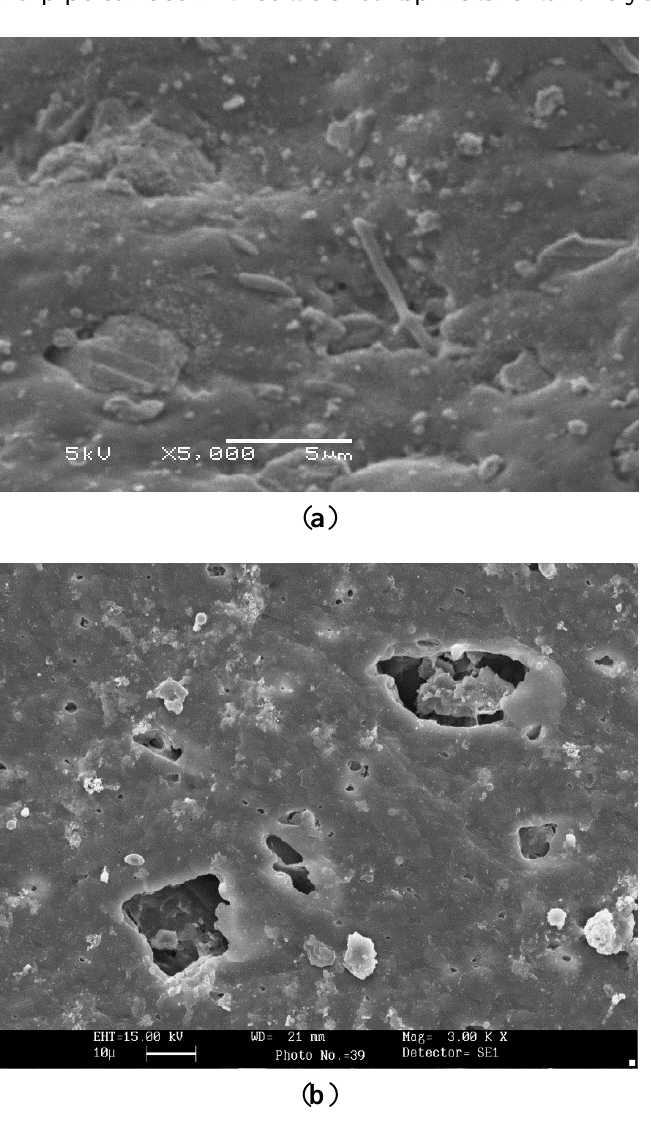
Figure 5. SEM photo of PVC pipes. ( a ) PVC pipe surface with tap water after one year of operation; ( b ) PVC pipe surface with autoclaved tap water after one year of